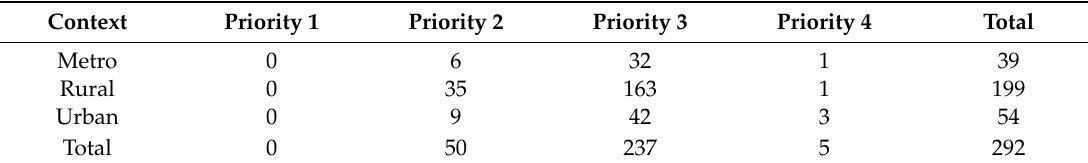
Table 1. Numbers of tasks by priority level and geographic